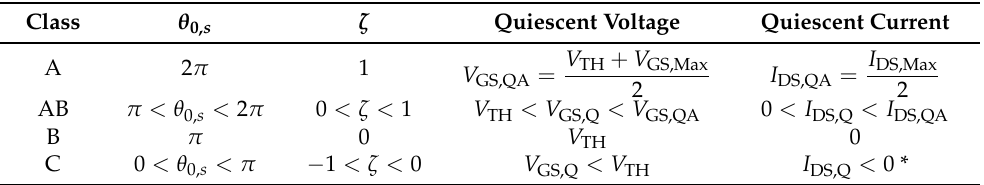
Table 1. Features of the different current-mode biasing classes.